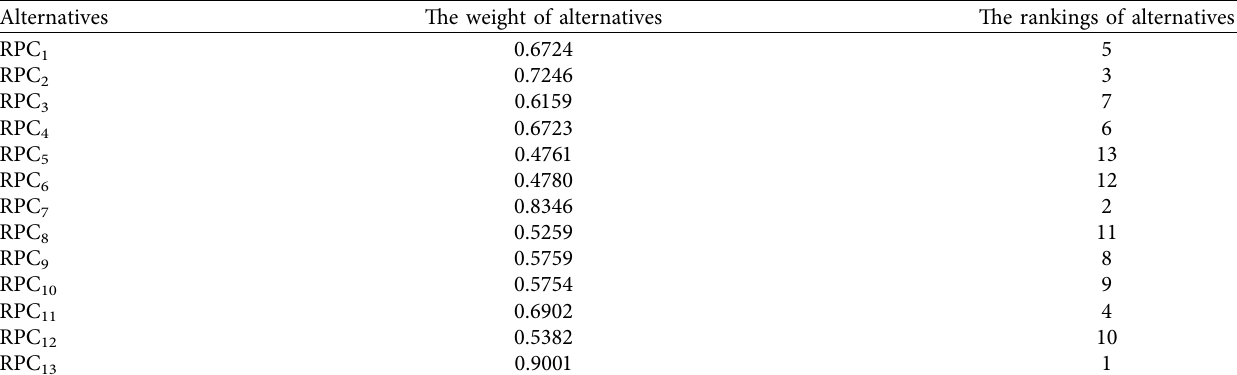
Table 10: Ranking RPC designs using SAW method.